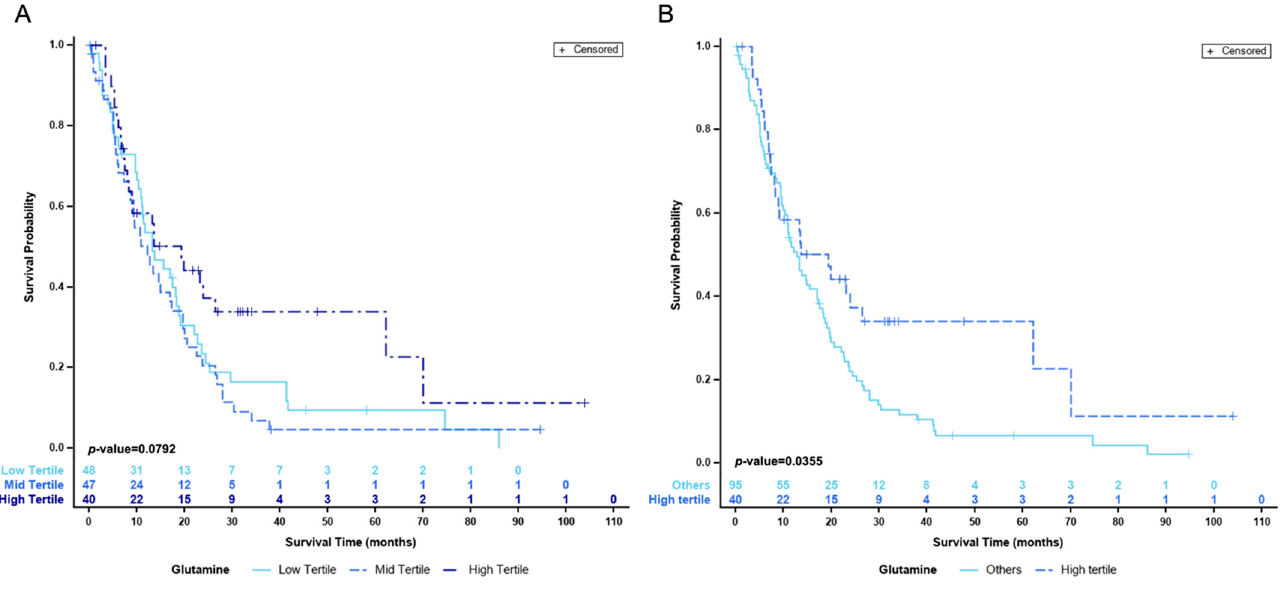
Figure 2. Actuarial survival curves ( A ) divided by terciles ( B ) comparing high tercile against mid and low groups. and low groups.